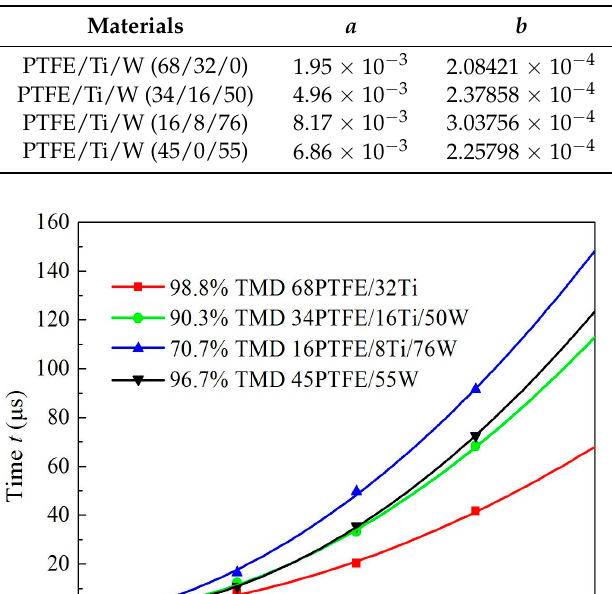
Table 3. Fitting coefficients of different experimental samples.